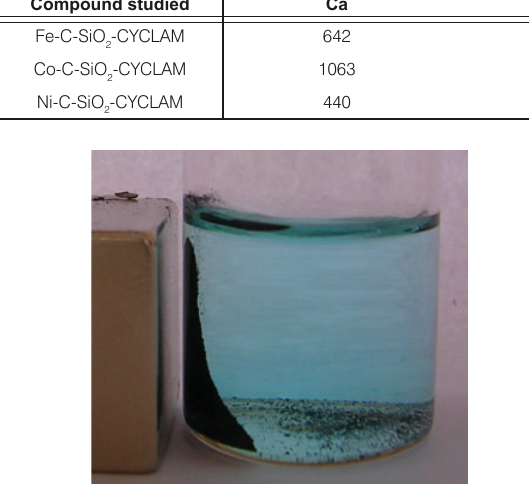
Figure 5. Presentation of magnetic properties of the supports studied in water